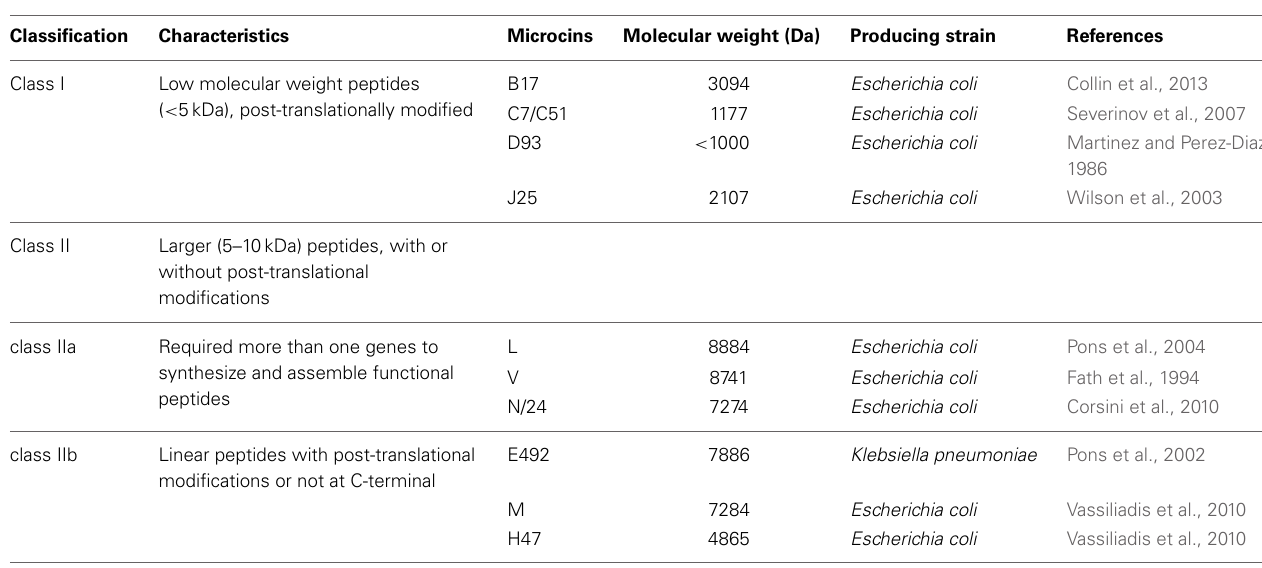
Table 2 | Classification scheme for gram-negative